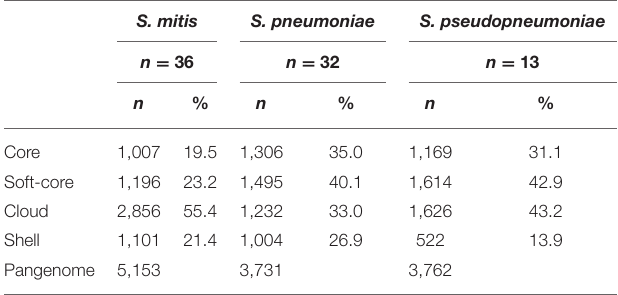
TABLE 2 | Pangenome distribution of the genes for each species, using 70C/70S (70% Contiguously aligned/70% sequence Similarity) criteria.